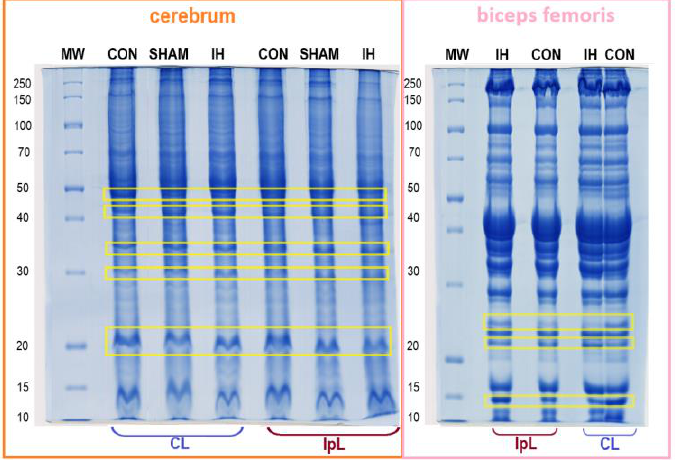
Figure 2. SDS-PAGE of pig brain and muscle biosubstrates: IH, convalescent pigs; SHAM, sham operated; CON, intact pigs; IpL, ipsilateral side; CL — contralateral side. Fractions selected for mass spectrometric studies are marked with yellow rectangles.